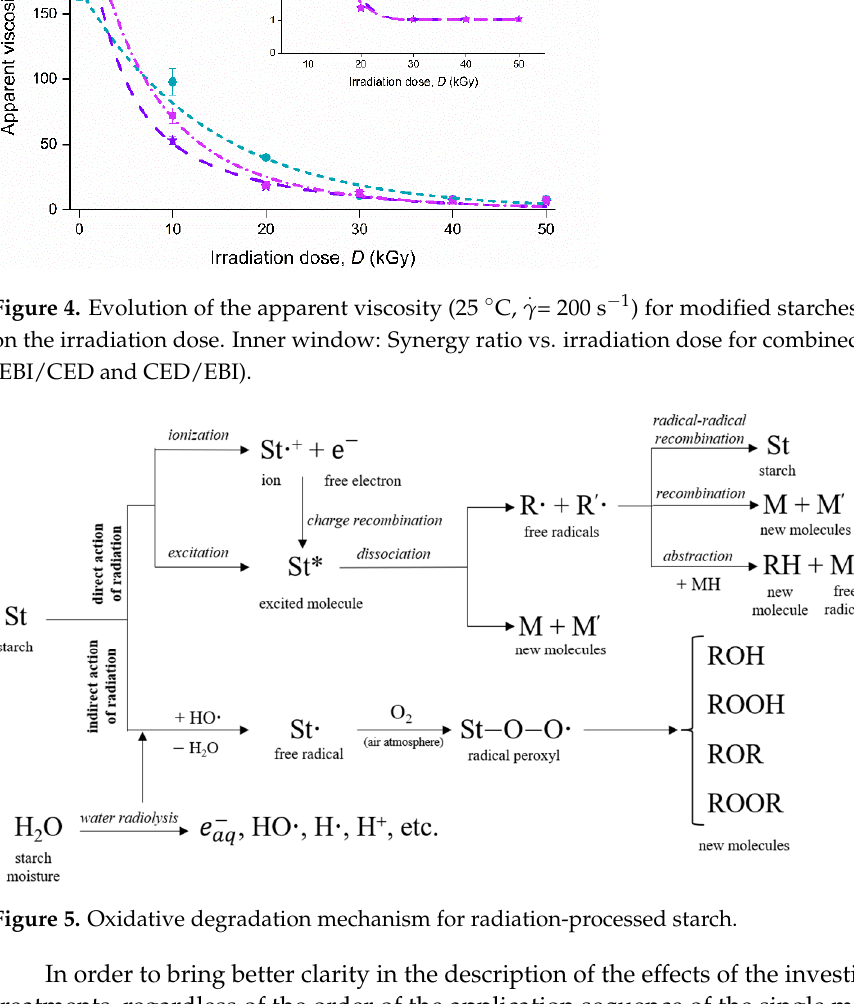
Figure 4. Evolution of the apparent viscosity (25 °C, γ  = 200 s − 1 ) for modified starches depending on the irradiation dose. Inner window: Synergy ratio vs. irradiation dose for combined treatments (EBI/CED and CED/EBI).